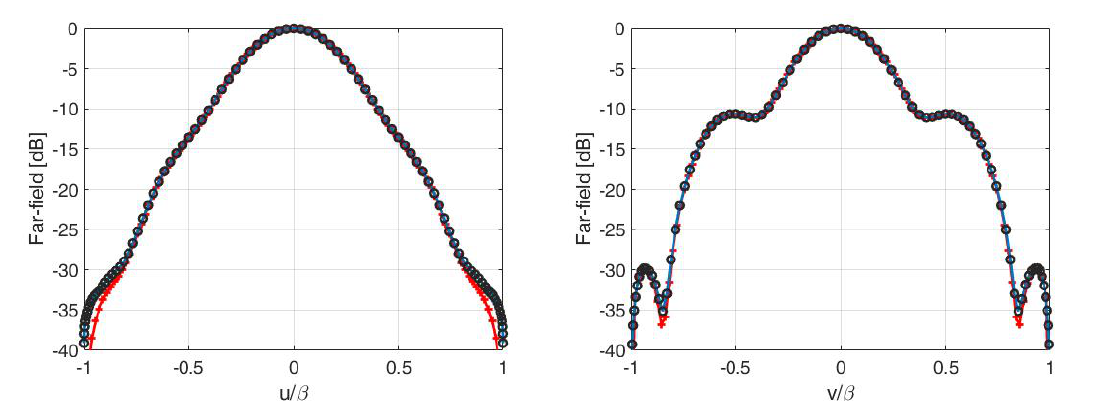
Figure 17. Cuts, along the u -axis ( left ) and v -axis ( right ), of the reference (red pluses) and reconstructed far-field using “optimal virtual” sensors (black circles) and SVO (blue solid